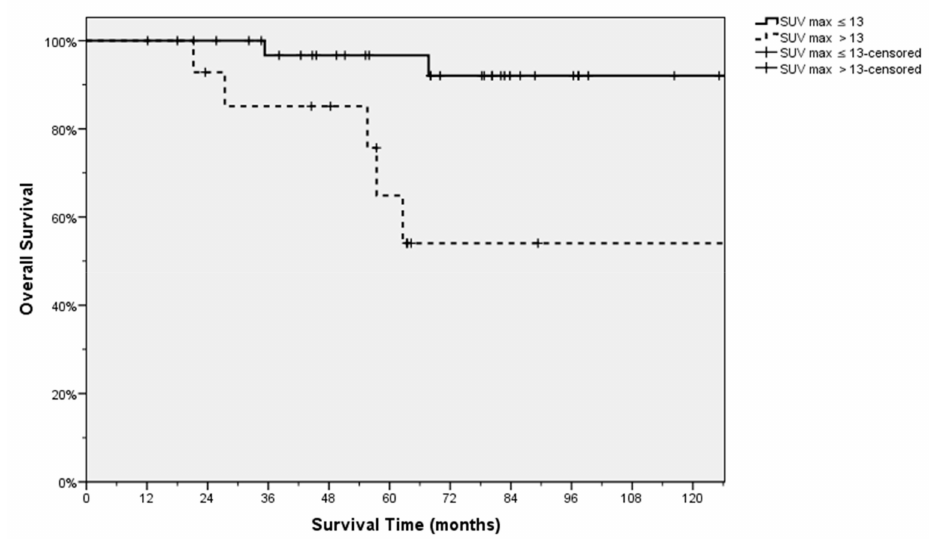
Figure 4. Di ff erent Overall Survival (OS) of the patients divided on the basis of the SUVmax